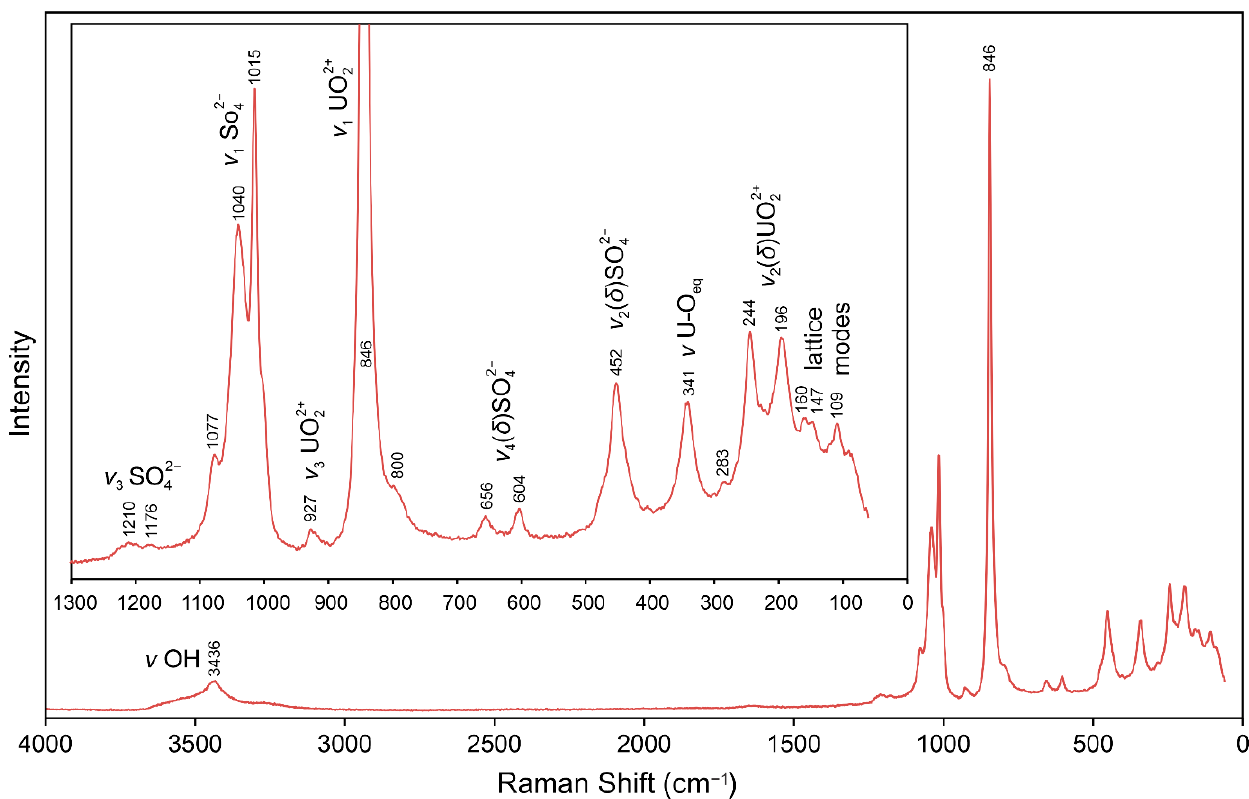
Figure 3. Raman spectrum of chenowethite recorded using a 532 nm diode laser. The band at 3436 cm − 1 with broad shoulders extending from about 3700 to 3200 cm − 1 is due to ν OH stretching vibrations. Using the empirically derived equation of [10], the